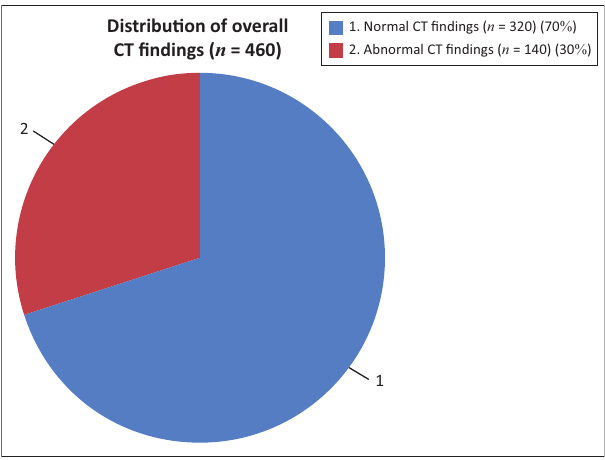
FIGURE 1: Pie chart demonstrating the distribution of normal and abnormal findings on computed tomography in our sample of patients ( n = 460).